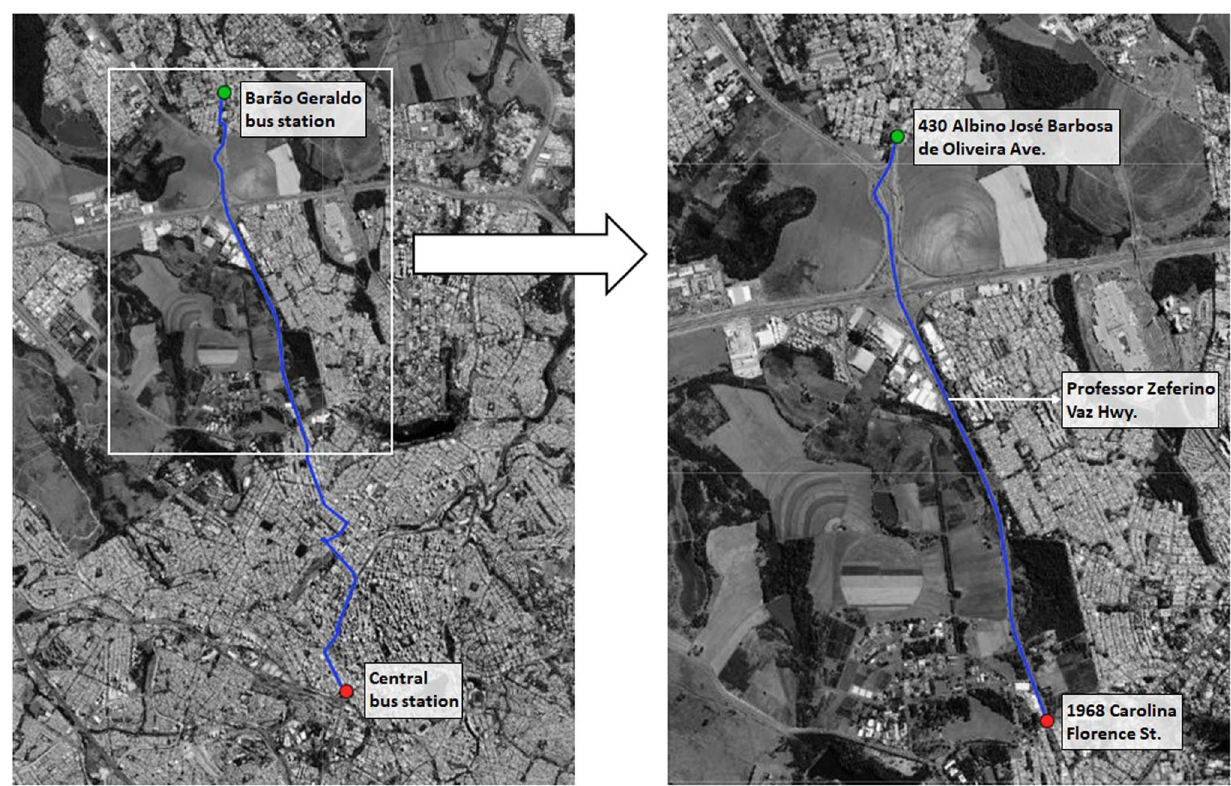
Fig. 4 Studied route (https:// www. maps.